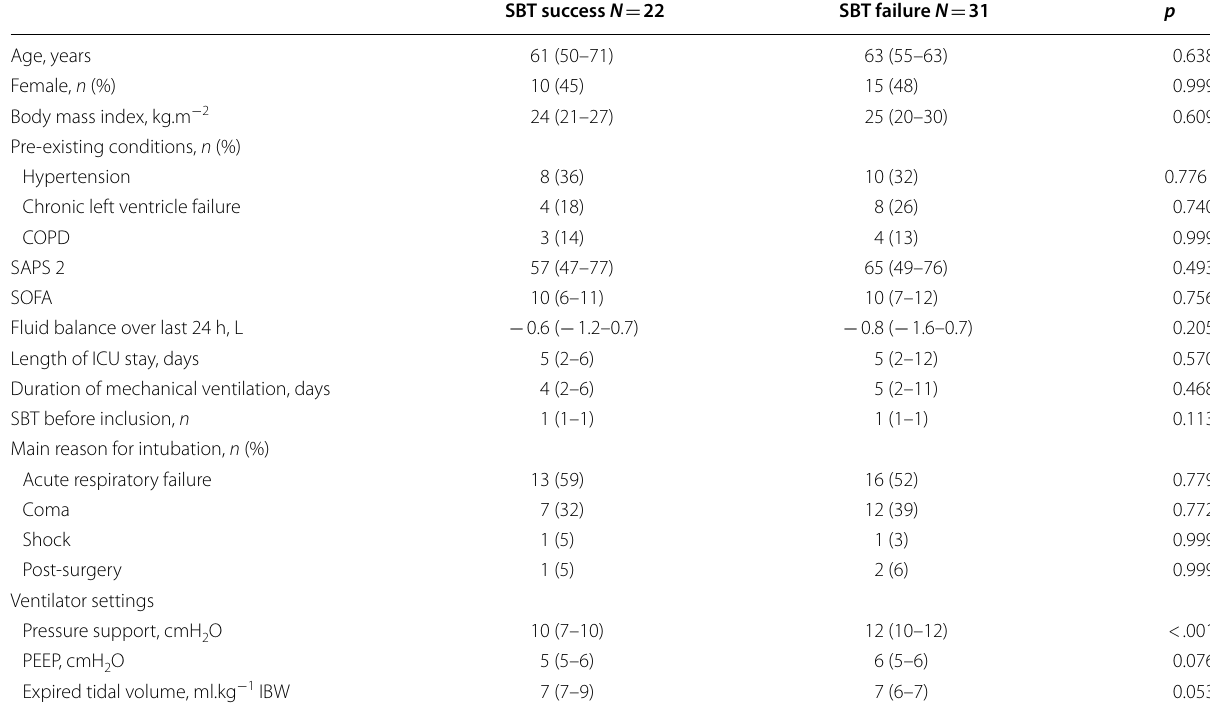
Table 1 Baseline patient